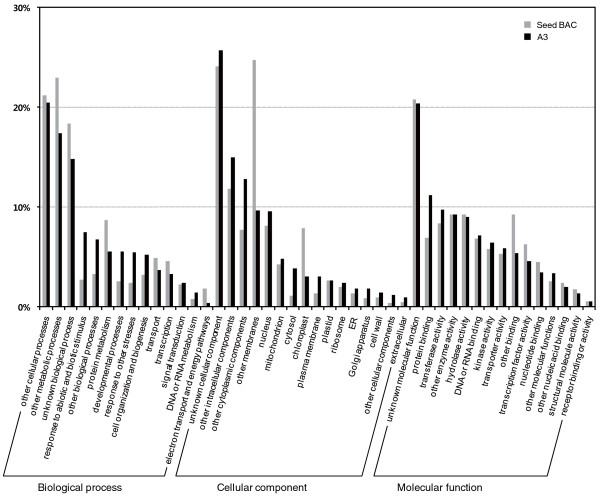
Functional classification of the proteins encoded on chromosome A3 or seed BAC sequences through annotation using Gene Ontology. Assignments are based on the annotations to terms in the GO biological process, cellular component, and molecular function categories.